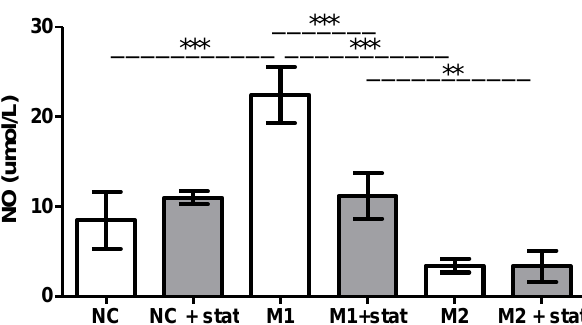
Figure 6. Concentrations of nitric oxide released into the medium by stimulated monocytes with or without statin. NC, negative controls, NC + stat, statin therapy for 48 h, M1, monocyte stimulation by lipopolysaccharides (LPS) and interferon-gamma (IFN- γ ) for 48 h, M1 + stat, monocyte stimulation by LPS and IFN- γ and statin therapy for 48 h, M2, monocyte stimulation by interleukin 4 (IL-4) and IL-13 for 48 h, and M2 + stat, monocyte stimulation by IL-4 and IL-13 and statin therapy for 48 h. Each bar expresses the results of 4 wells in mean ± SD. ** p < 0.01 and *** p < 0.001.